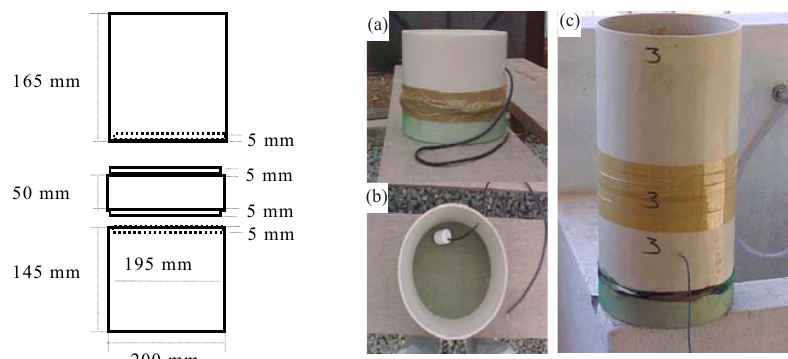
Figura 1. Esquema representativo da unidade experimental utilizada, anel inferior com fundo em tela antiafídeos (a), Detalhe do sensor (bloco de Bouyoucos) (b) e Unidade experimental montada (c) composta por anéis sobrepostos de PVC